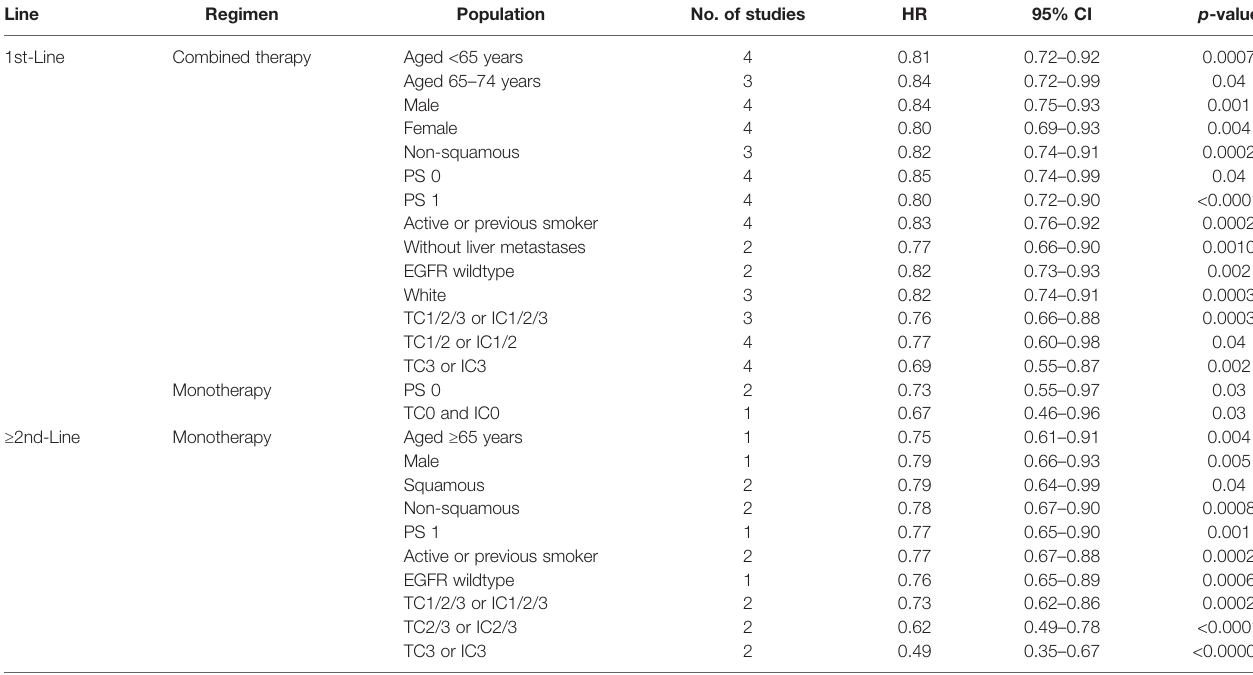
TABLE 2 | Different treatment lines and regimens with OS bene fi ted from atezolizumab-based therapy over chemotherapy-based therapy in targeted patients. Line